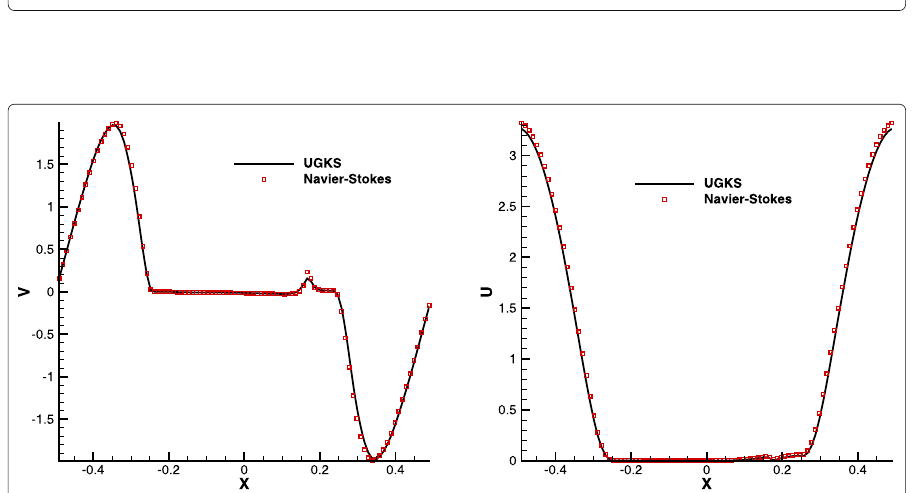
Fig. 9 The comparison of UGKS and NS velocity profile along y = 0.25 for the micro flow through periodic square cylinders